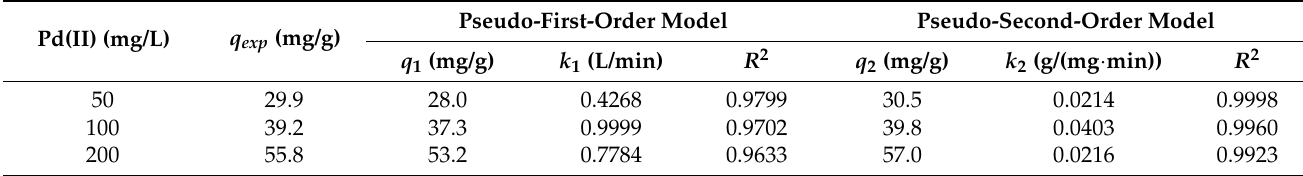
Table 4. Kinetic parameters of Pd(II) adsorption onto PEI-chitin at different initial Pd(II) concentrations. Pseudo-First-Order Model Pseudo-Second-Order Pd(II) (mg/L) q exp (mg/g)